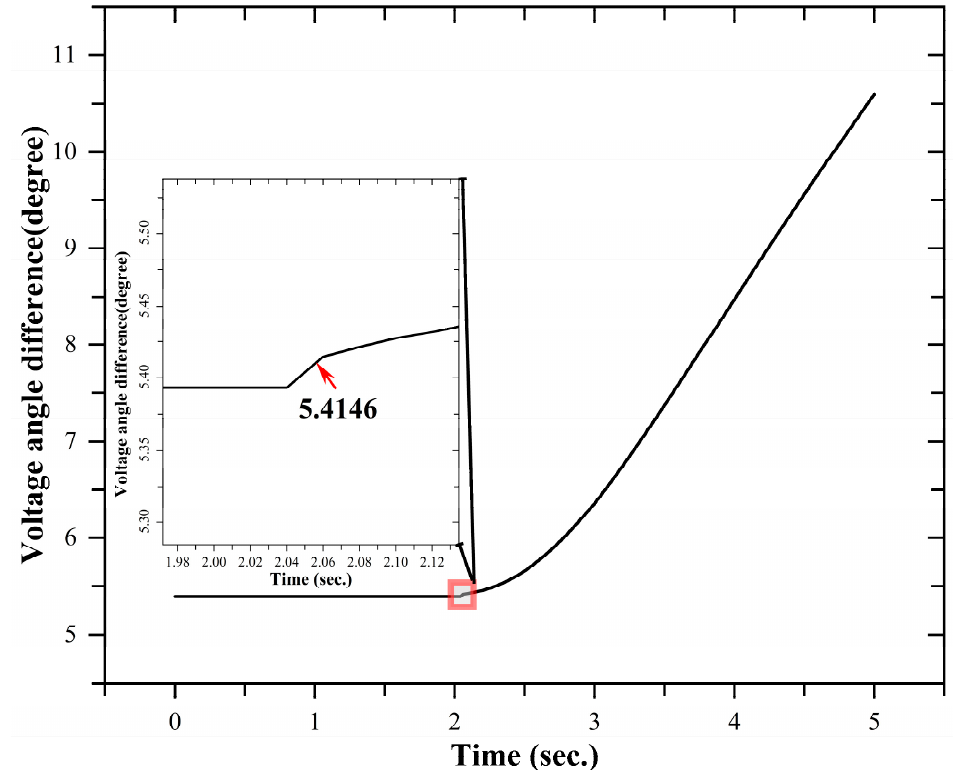
Figure 18. Proposed unintentional island threshold technique for over frequency Scenario 4.